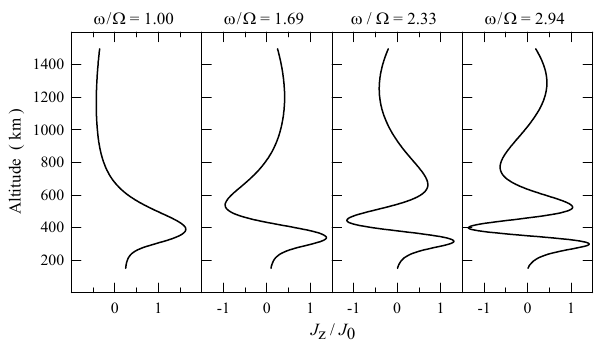
Fig. 5. Altitudinal distributions of relative values of the field- aligned current J z / J 0 for four resonant frequencies at fixed points in time t which correspond to J z / J 0 maximum in the